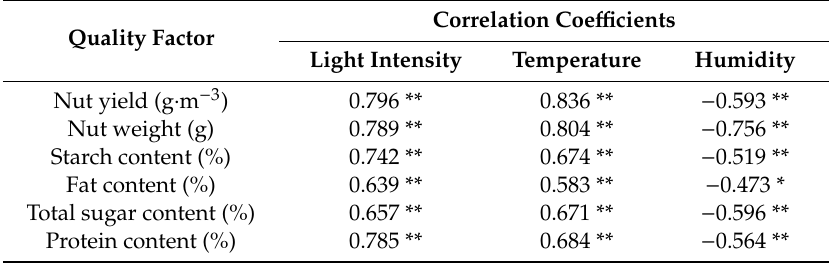
Table 4. Correlations between the canopy microclimate and nut yield and